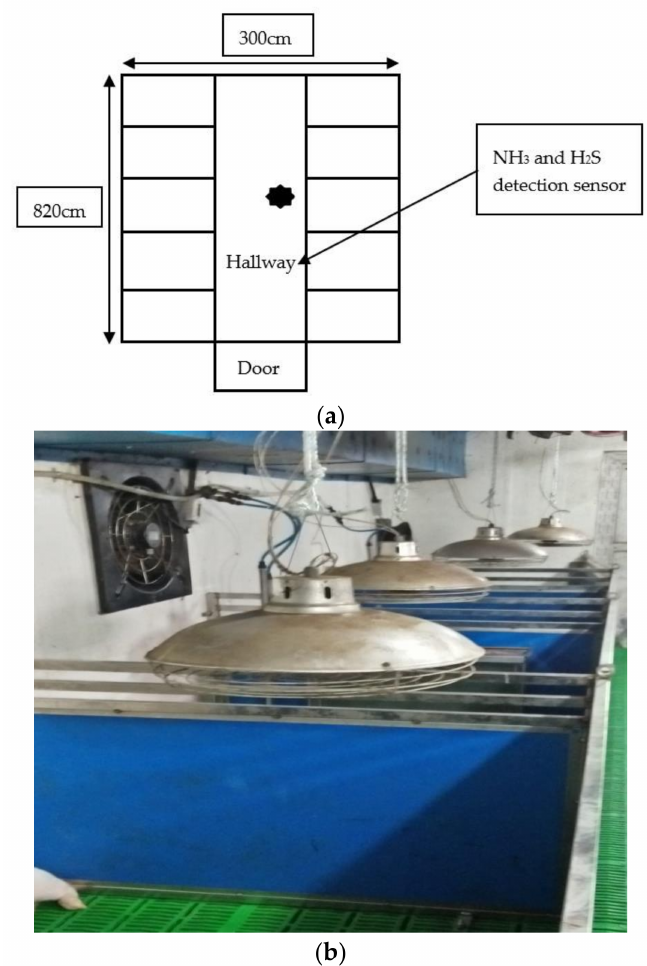
Figure 1. ( a ) Schematic diagram of the pig house with the location of sensors for the detection of noxious gases (NH 3 and H 2 S); ( b ) inside view of control pig house with electric heating